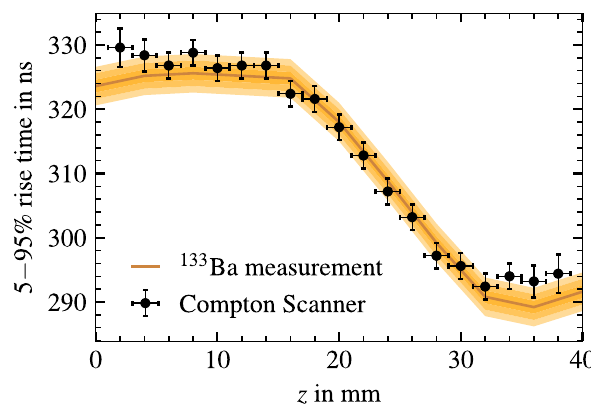
Fig. 16 5 − 95% rise times, t r , as determined from core superpulses for the same source position and detector temperature as the pulses in Fig. 15. Vertical error bars and confidence bands correspond to devia- tions from t r when determining the rise times from superpulses of only a subset of pulses. Horizontal error bars correspond the z range used to determine Compton